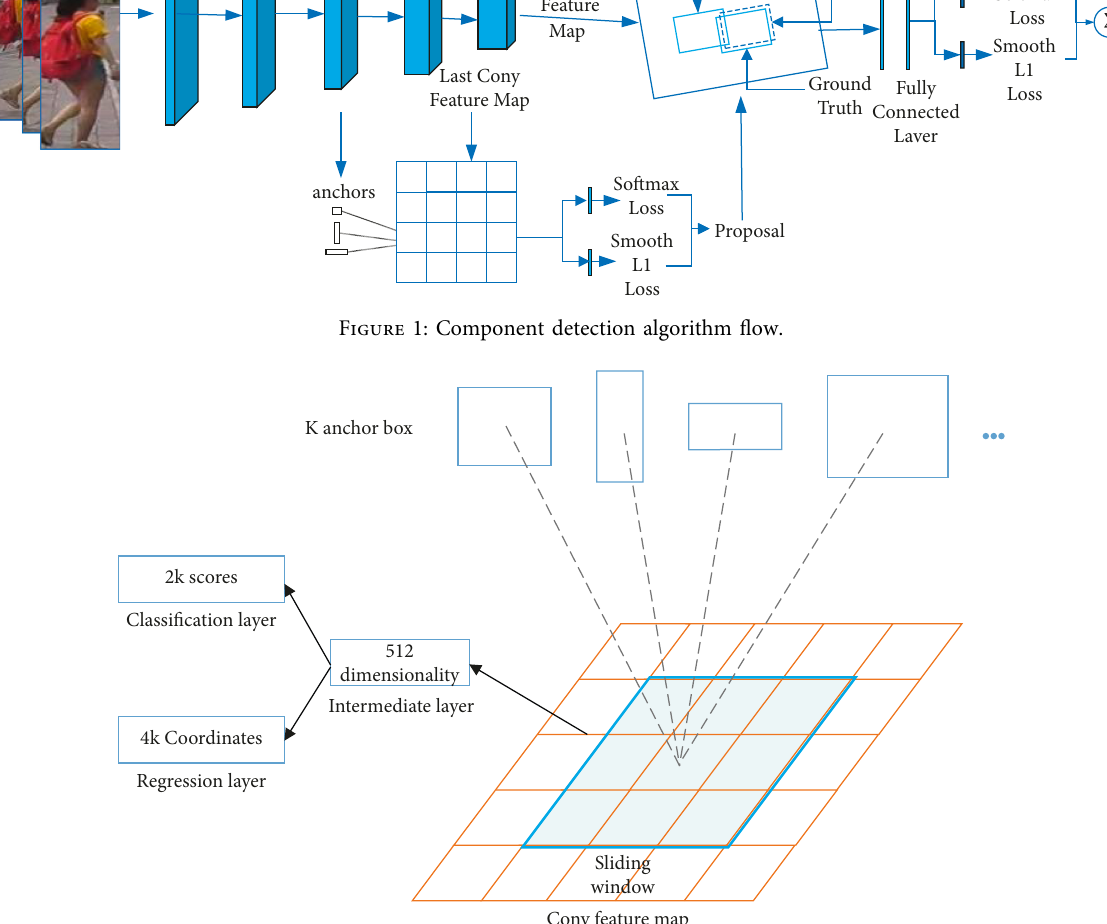
Figure 2: The schematic diagram of regional